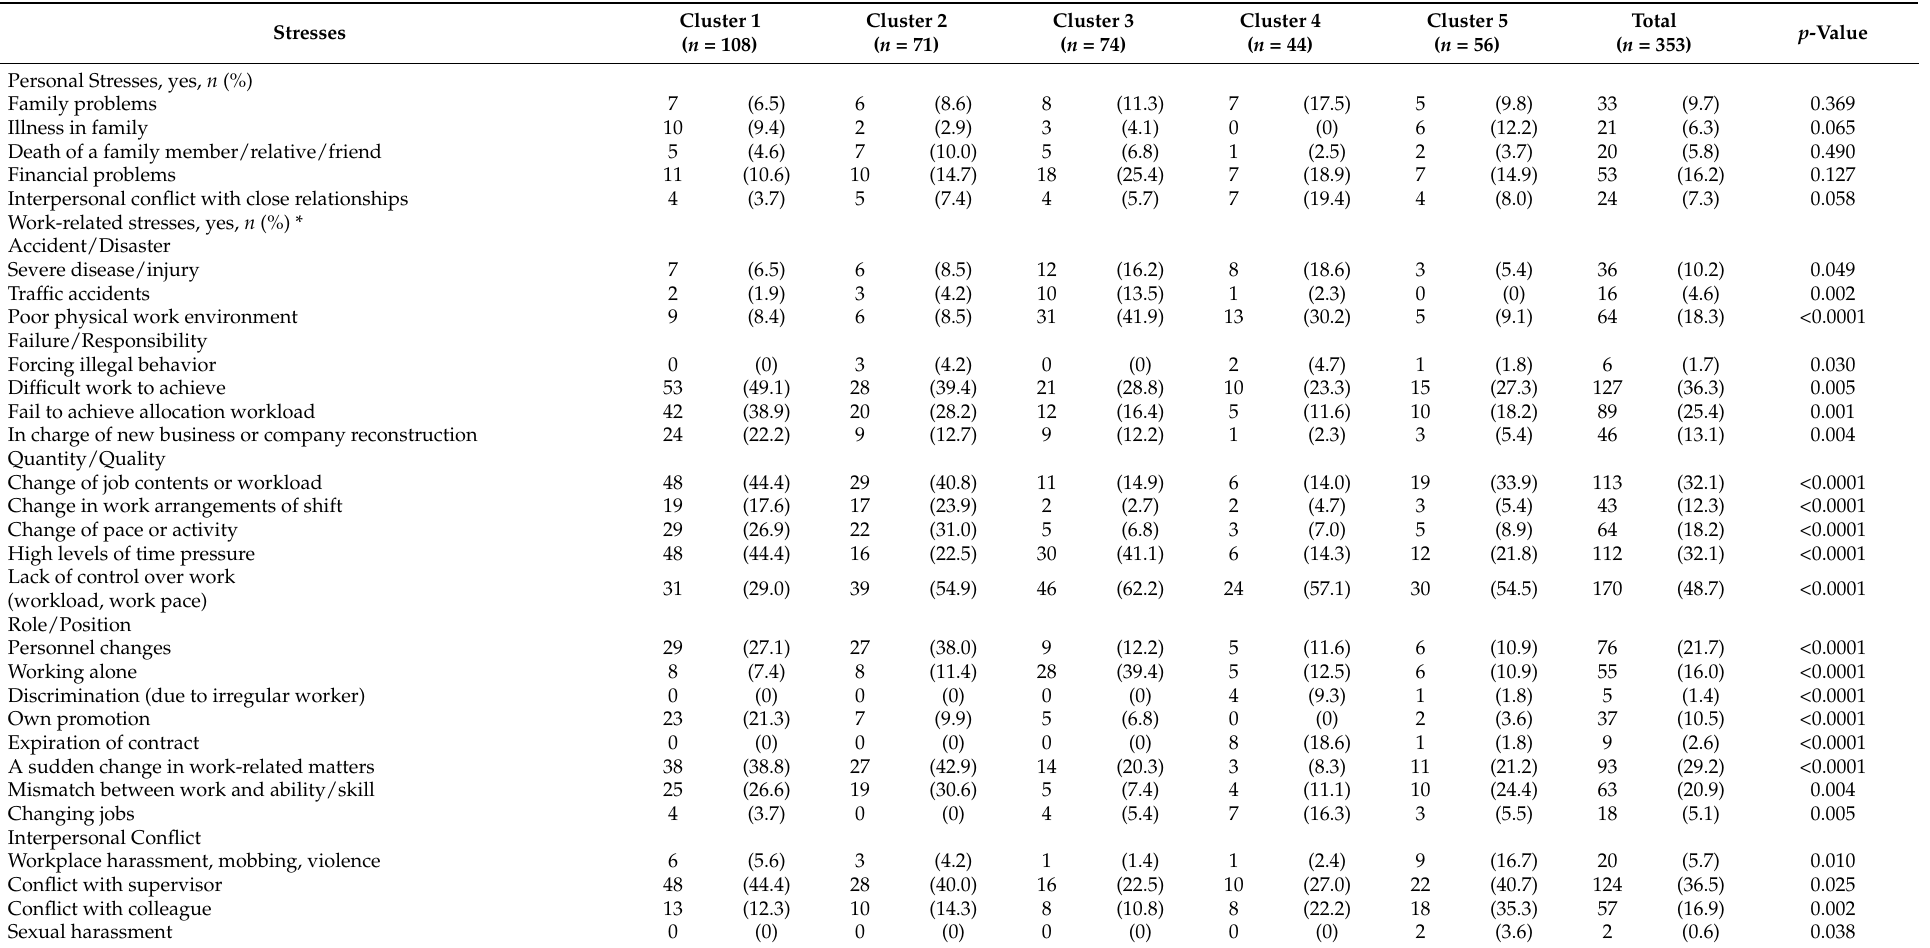
Table 3. Comparison of personal stresses and work-related stresses for five clusters of worker suicide